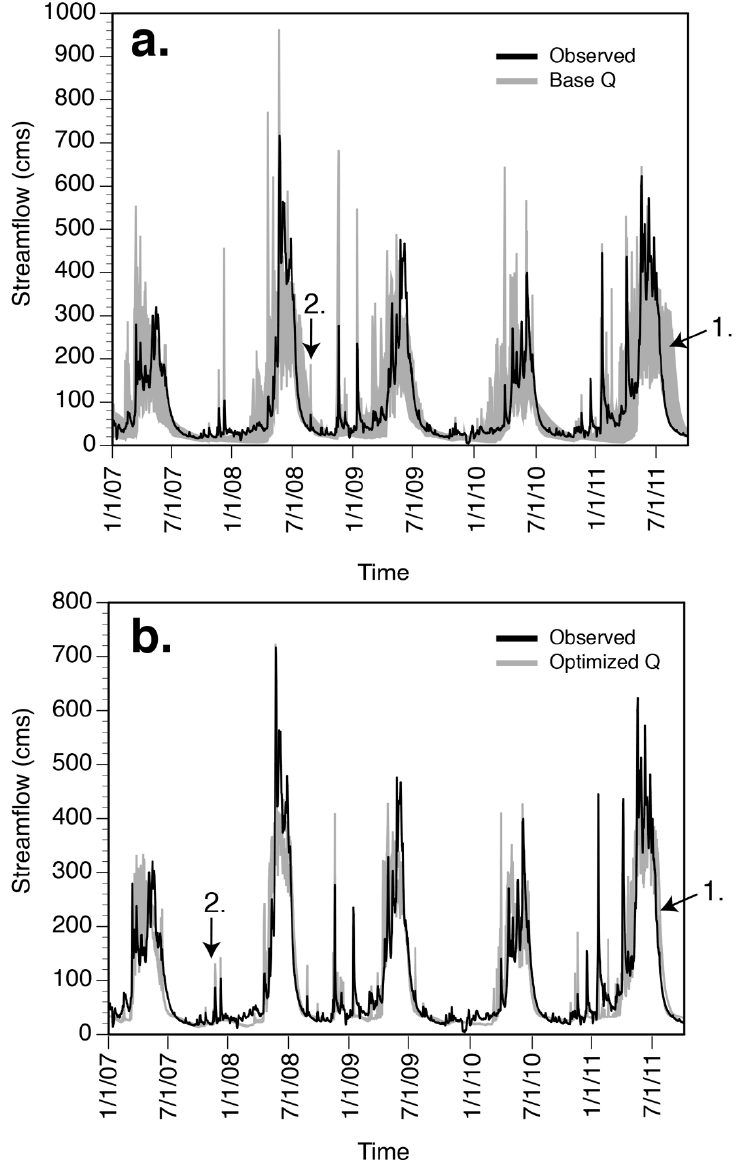
Figure 3. Streamflow hydrographs for the calibration period. (a) Base Q scenario versus observed streamflow. (b) Optimized Q scenario versus observed streamflow. Arrows 1 point to recessional flow and arrows 2, peak flows outside the main snow melt season.